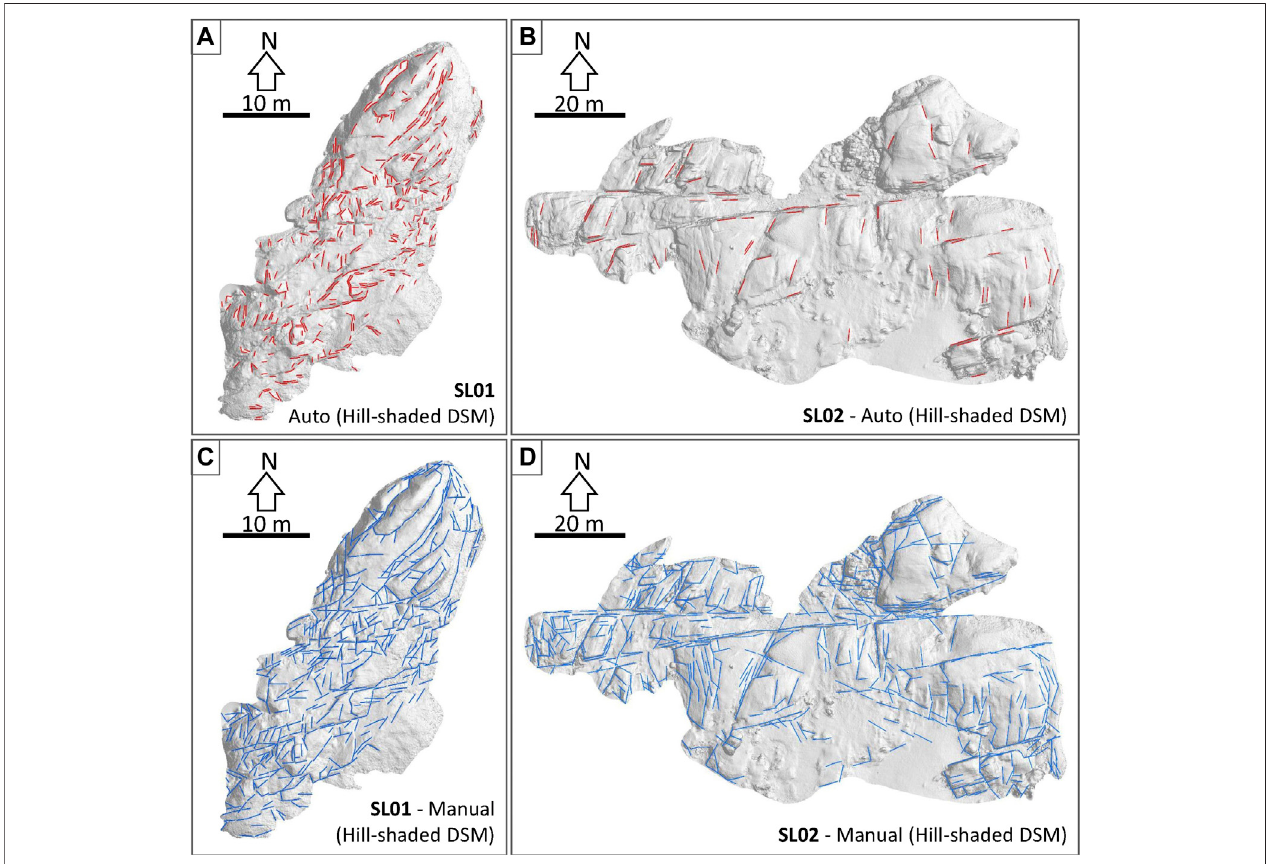
FIGURE4| Imagesofhill-shadedDSMoftheoutcropscapturedfromthetop,withcoloredlinesasthefracturelinesonbothoutcrops.Lineamentsatpanels (A,B) are generated automatically, whereas lineaments at panels (C, D) are the result of manual interpretation.